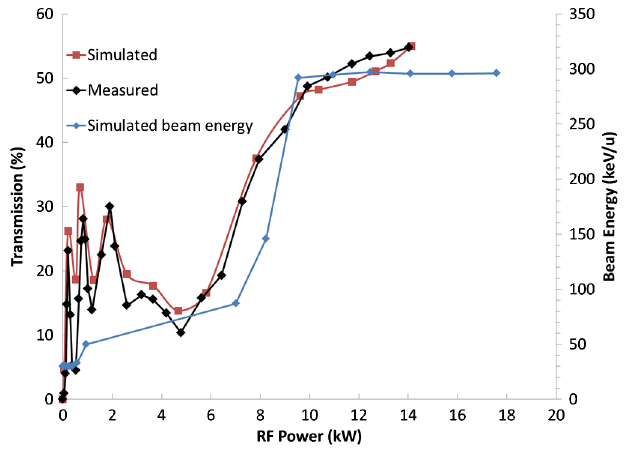
FIG. 17. Measured and simulated beam transmission as a function of rf power along with the simulated beam average energy.